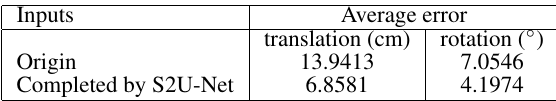
Table 1. The errors of point cloud registration using different